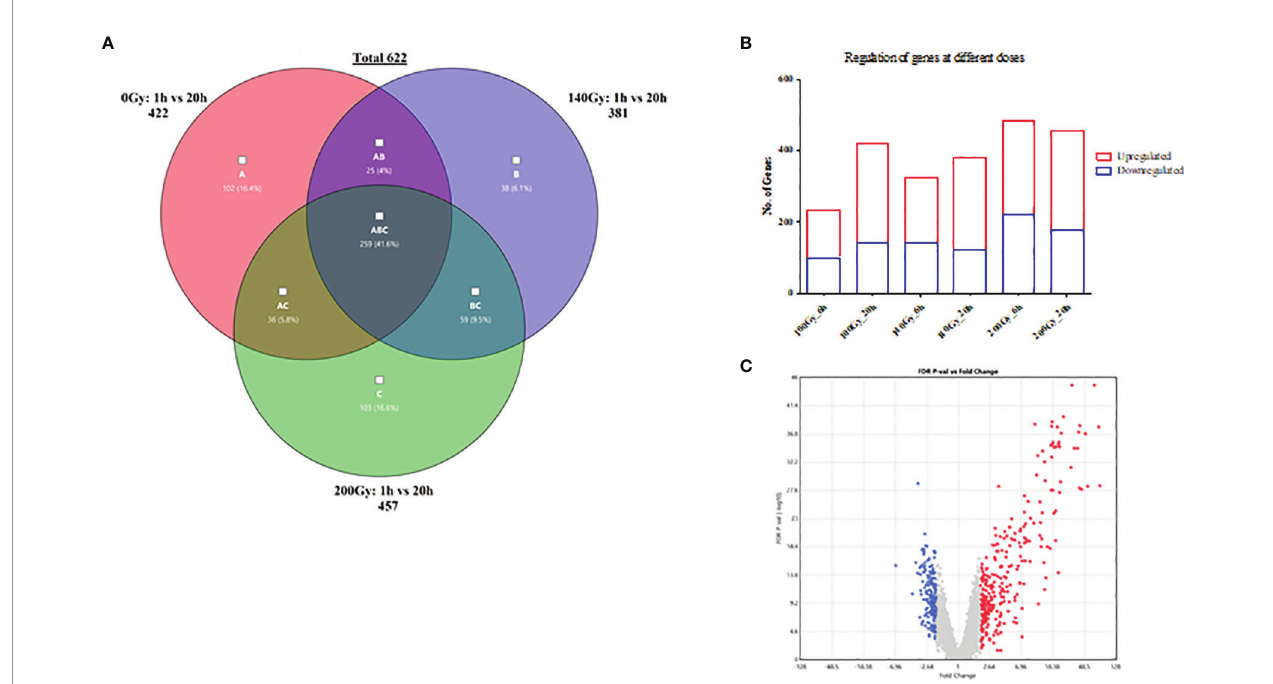
FIGURE 5 | General differences in gene transcript changes according to dose and time post-irradiation. (A) Bar graph showing the ratio of gene transcript abundance upregulated to downregulated at different doses at 6 and 20 hours post-irradiation. (B) Volcano plot of fold-change (FC) vs false discovery rate (FDR) p value for 200Gy irradiated parasites at 20h. (C) Venn diagram describing the distribution of 622 differential gene transcripts at 20 hours after irradiation with 259 genes common across all three doses when compared to 1 hour after irradiation, 102, 38 and 103 unique to 100Gy, 140Gy and 200Gy irradiation